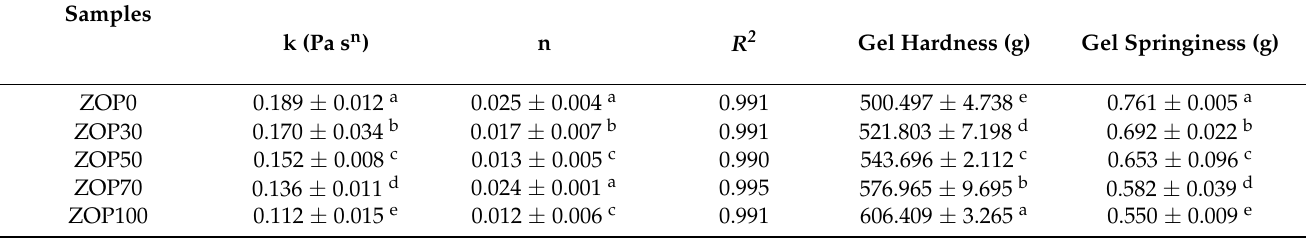
Figure 3. The storage modulus (G ′ ) and loss modulus (G ′′ ) curves of five gels, and the curves of tan δ of five gels changing with angular frequency.